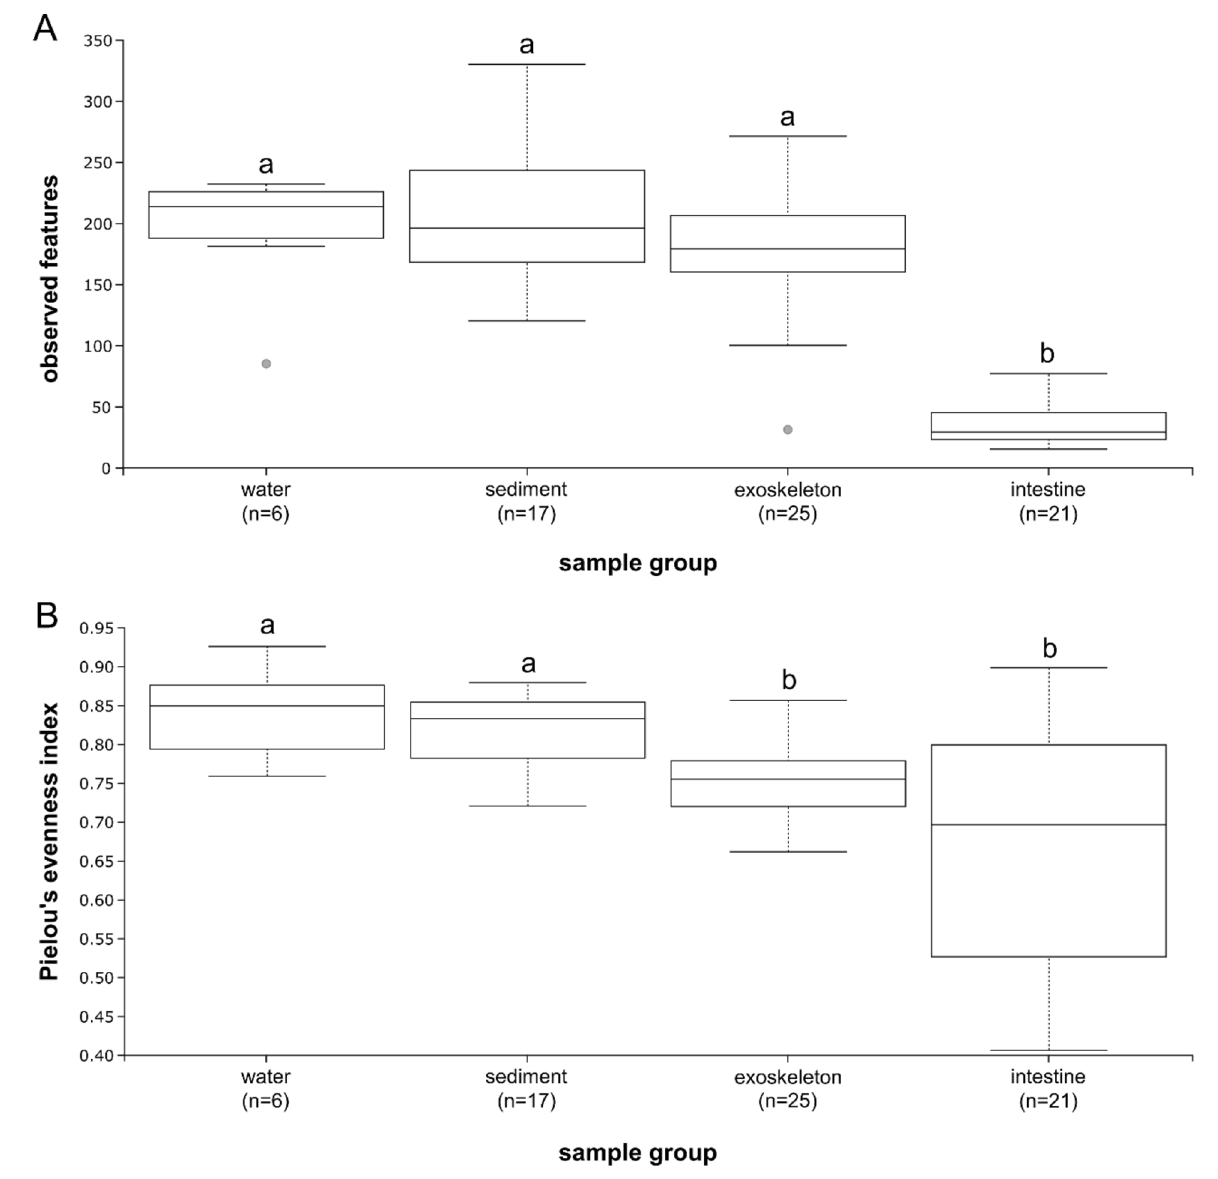
Fig. 1 Alpha diversity analyses showing (A) the number of observed features and (B) the Pielou’s evenness index for mycobiomes from different sample groups. Significant differences are marked with different